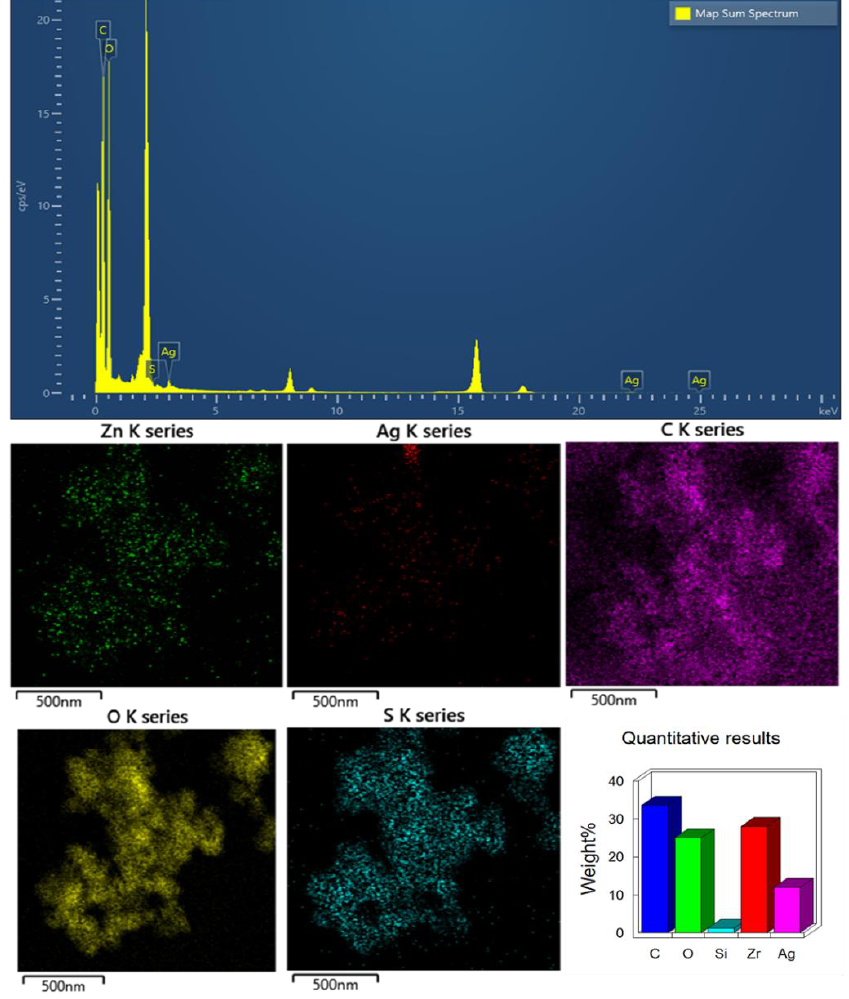
Figure 3. EDS mapping of ZrO 2 -Ag-G-SiO 2 Samples.